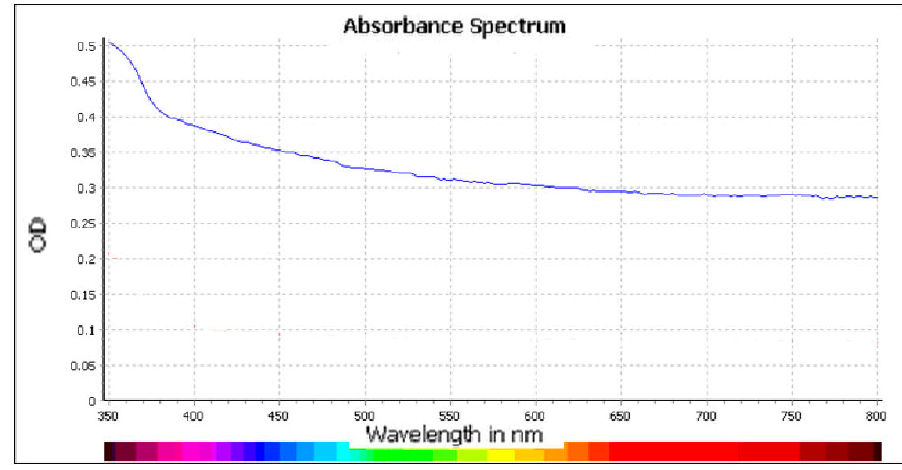
Figure 2. UV spectra of TiO 2 -NPs.